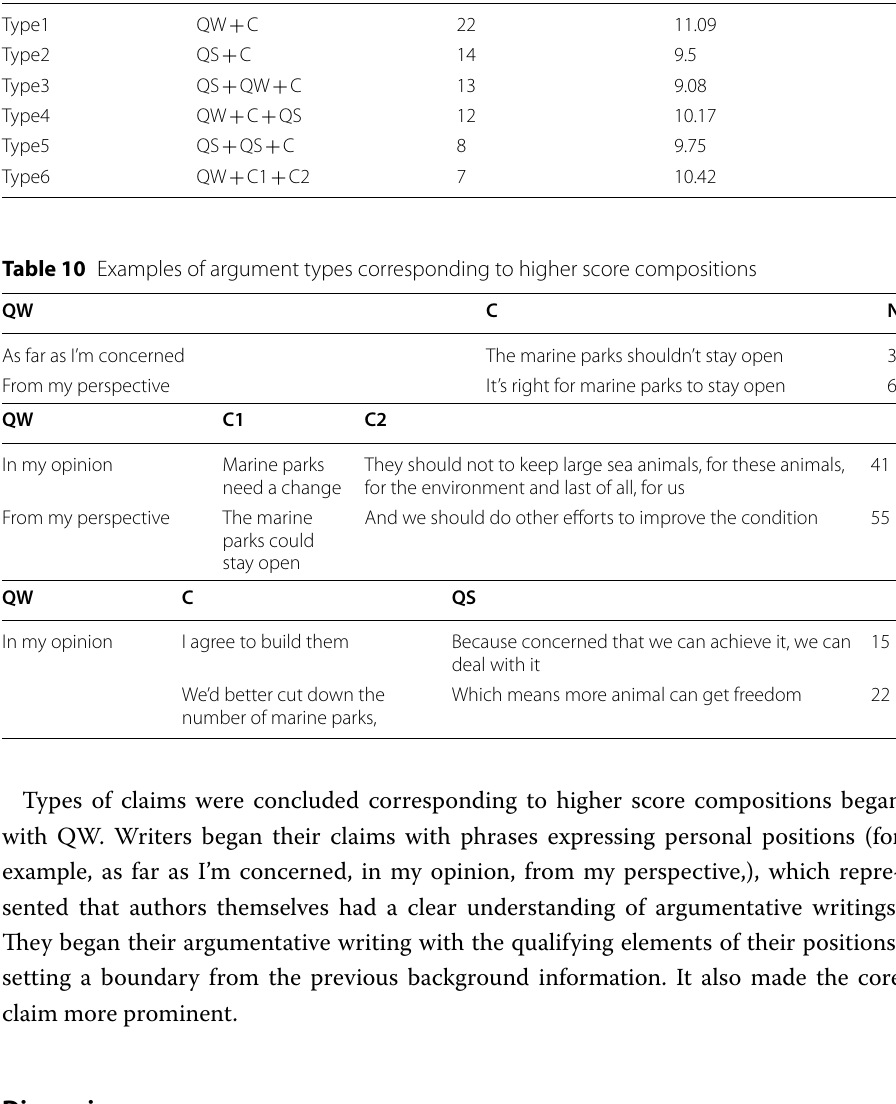
the corresponding